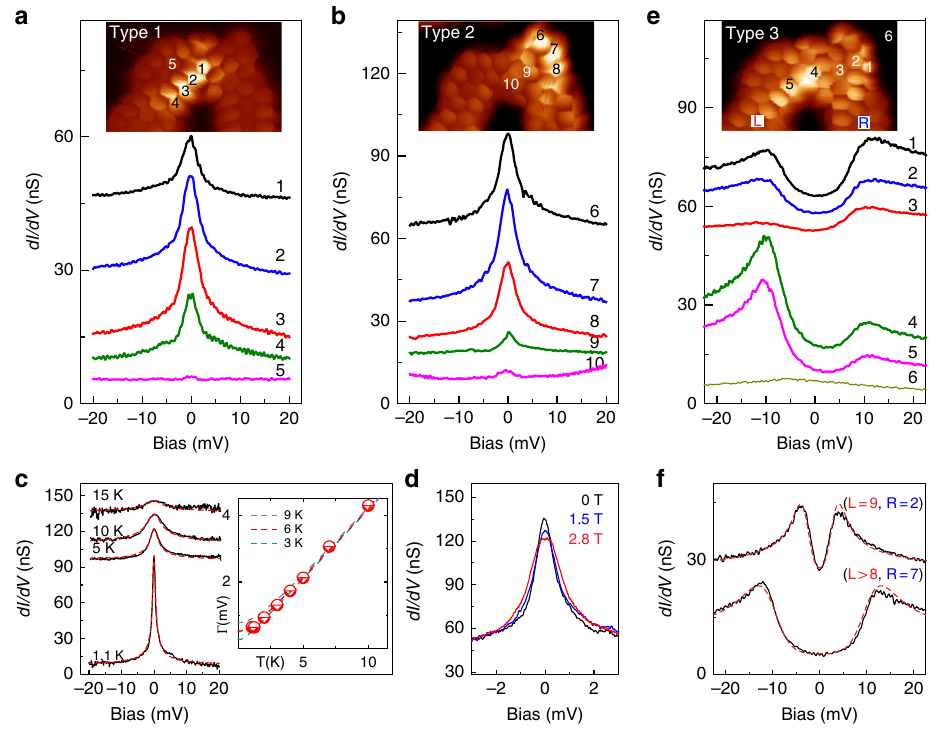
Fig. 2 Zero bias spectral features. a , b Kondo resonances over the bright regions of Type 1 and Type 2 junctions, respectively. The zero-bias peaks are mostly detected over four PC rings of Type 1 junctions and over three ZZ rings of Type 2 junctions. c Temperature dependence of the Kondo resonance. All spectra were measured over the same PC site. The half width at half maximum (HWHM) at each temperature is extracted by fi tting a Frota function (red dashed lines) 49 and corrected for the thermal broadening of the tip 28 . The temperature dependence of HWHM was simulated with the empirical ffiffiffiffiffiffiffiffiffiffiffiffiffiffiffiffiffiffiffiffiffiffiffiffiffiffiffiffiffiffiffiffiffiffiffiffiffi q α k T ð Þ 2 α = 9.5 (Supplementary Note 3). 29 , which reproduces the experimental results with a Kondo temperature T expression 1 K ~ 6 K and B 2 d Magnetic fi eld dependence of a Kondo resonance (over the same PC site) at the fi eld strengths indicated in the fi gure. e Double-peak features around zero bias over Type 3 junctions. f Split-peak d I /d V features for nanostructures with different sizes, determined by the number of precursor units in each chGNR, labeled L and R in e . The gap width increases with the length of the ribbons (see Supplementary Fig. 16a in Supplementary Note 8). The red dashed lines are fi ts to our spectra using a model for two coupled spin-1/2 systems 31 . The spectra in c , d were acquired with a metal tip, while the others with